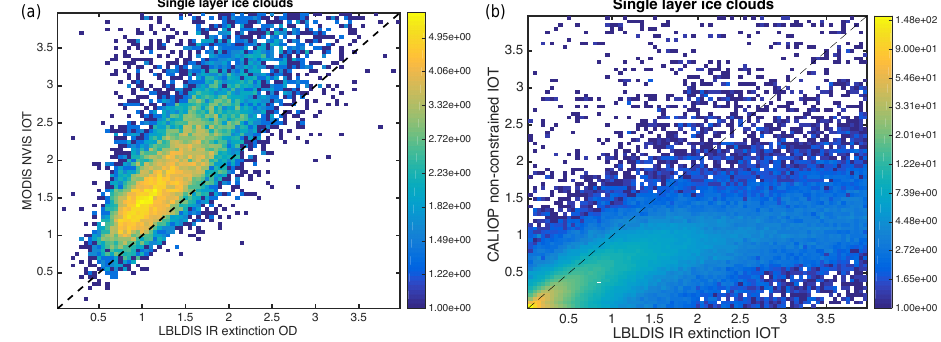
Figure 3. Two-dimensional histogram comparing the MODIS C5 (a) and CALIOP V3 (b) retrievals to the reference IR IOT retrieval.